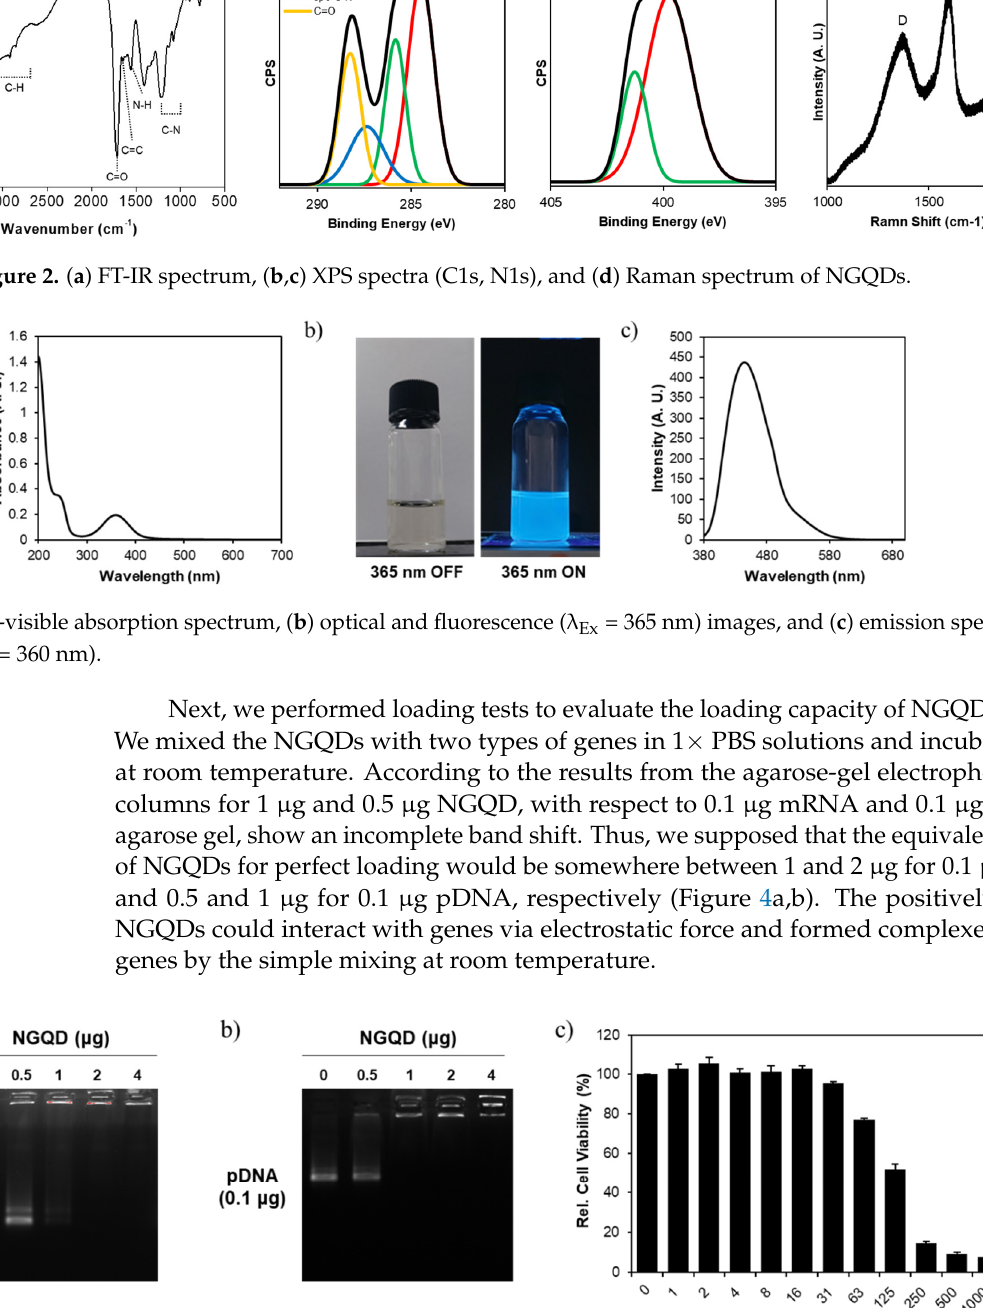
Figure 4. Loading capacity of NGQDs to ( a ) mRNA and ( b ) pDNA. ( c ) Relative cell viability of NGQDs.